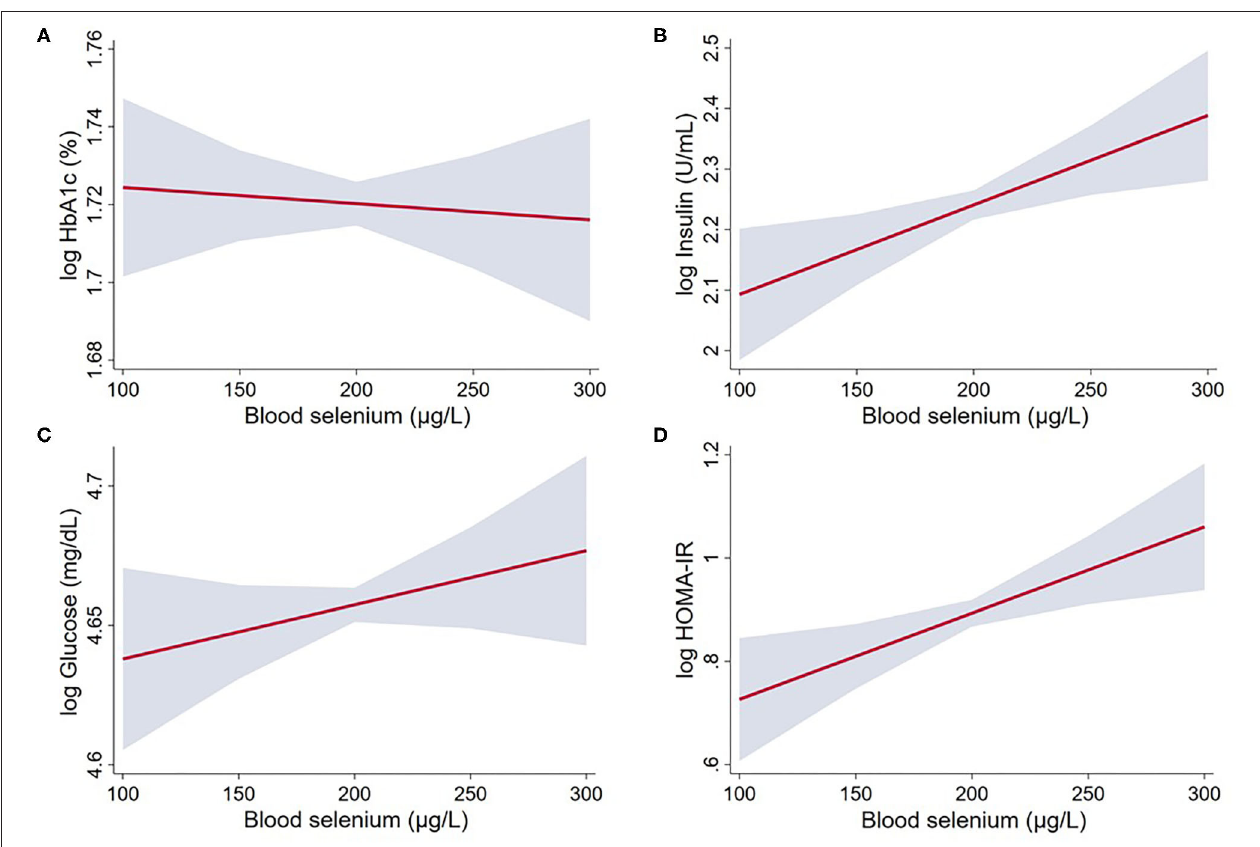
FIGURE 2 | Linear regression between whole blood selenium concentration and glucose and insulin markers in US adults from NHANES 2013 to 2018: (A) log HbA1c; (B) log Insulin; (C) log Glucose; and (D) log HOMA-IR. The associations were adjusted for age, sex, smoking status (smoker/non-smoker), physical activity, metabolic syndrome, BMI (Model 2). Gray area represents the 95% confidence intervals. Statistical parameters for these variables are given in Table 2